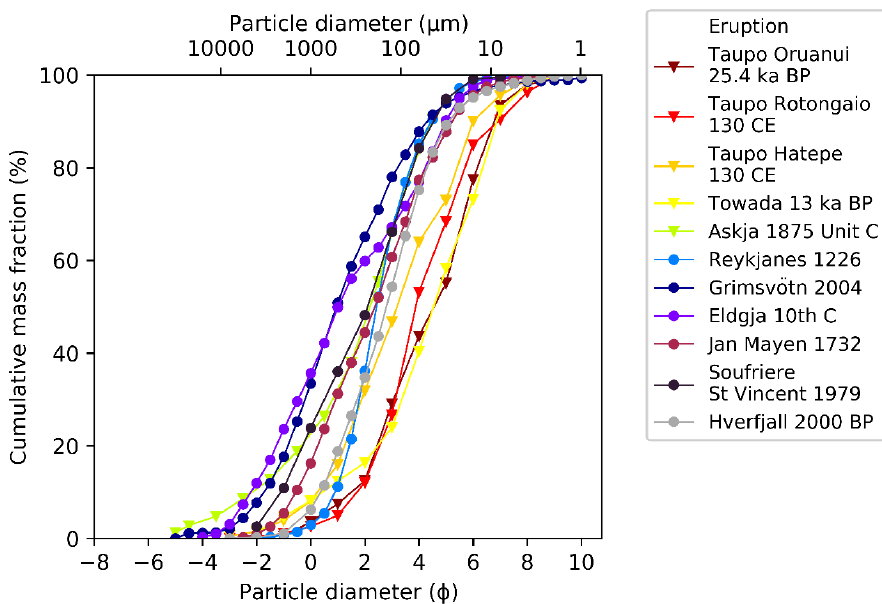
Figure 1. Total grain size distributions for hydromagmatic eruptions based on deposits. The legend lists eruptions in order of VEI (large to small; see Table 1). Magma composition: ▽ silicic, o mafic/intermediate.